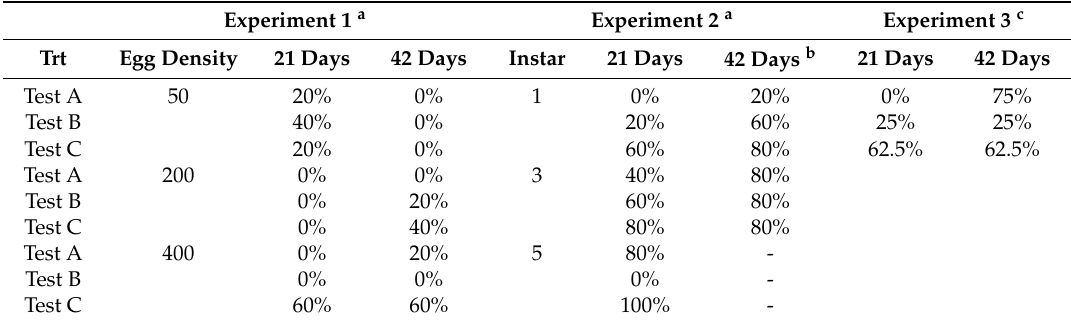
Table 1. Percentage of packages penetrated by P. interpunctella in each of the three